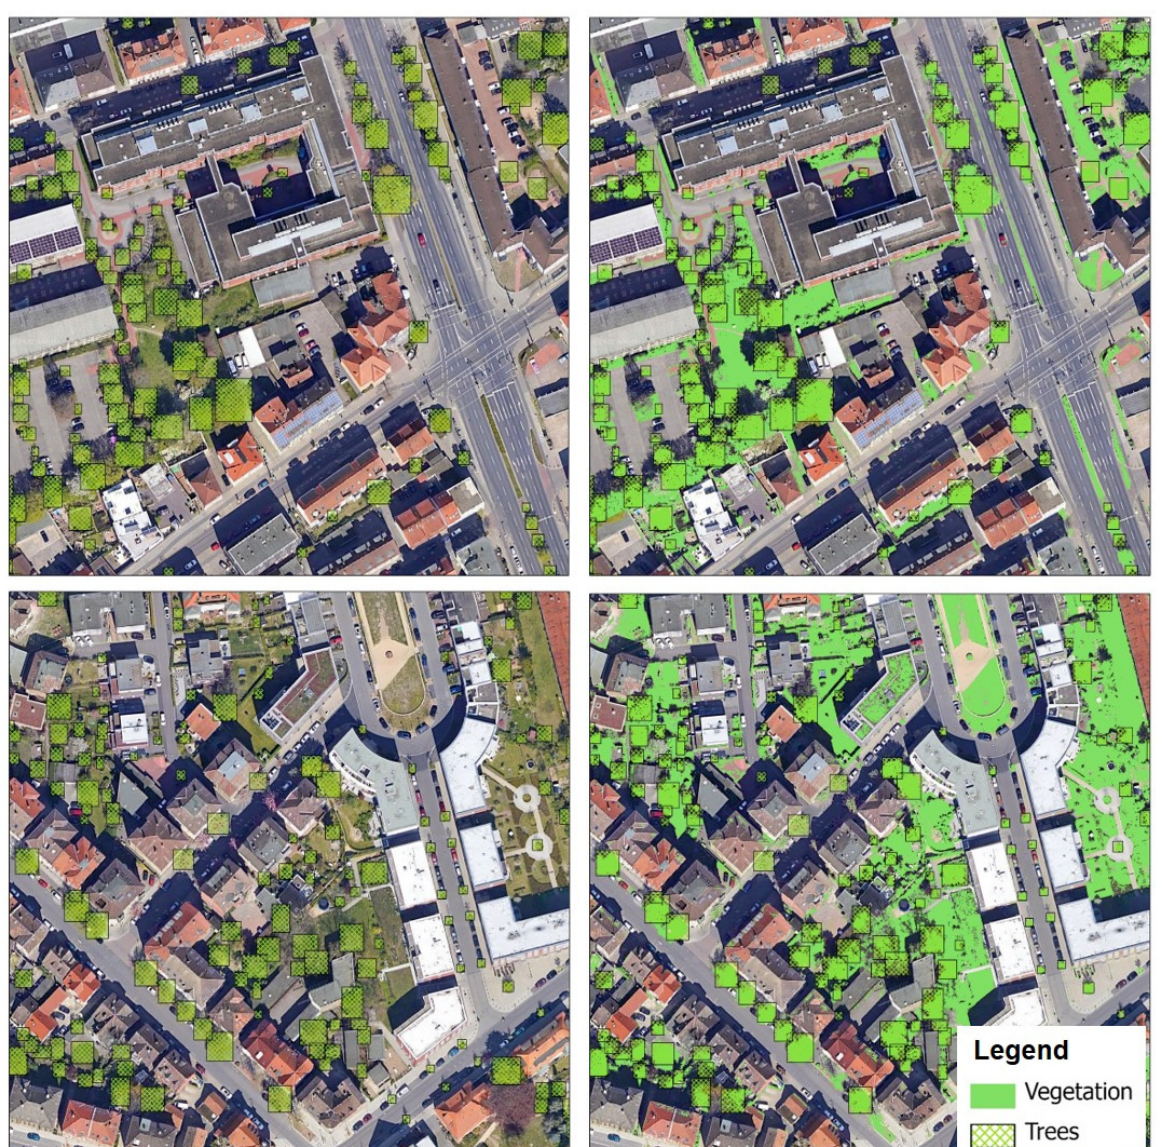
Figure 6. Tree detection and Vegetation classification output in the study area. Apart from the Tree detection, Iso clustering unsupervised classification is conducted on the imagery of the study area for classifying vegetation. The main objective of this task was to isolate green pixels, which is done by selecting a few of the obtained classes from unsupervised classification and reclassifying them as vegetation. The process results are promising ( IoUs of 0.812) and can delineate roadside greenery with great precision (Figure 6). The only downside of utilizing this approach is that it only picks up the green spectral signature, which might not represent the entire area with vegetation. Furthermore, depending upon the image acquisition time, the foliage may exhibit various textures, patterns, and colors, which might be difficult to capture via this method. The alternative strategy would be to utilize semantic segmentation and annotated labels. However, the results from the unsupervised classification fulfilled the purpose of this study; hence segmentation approach was not used.